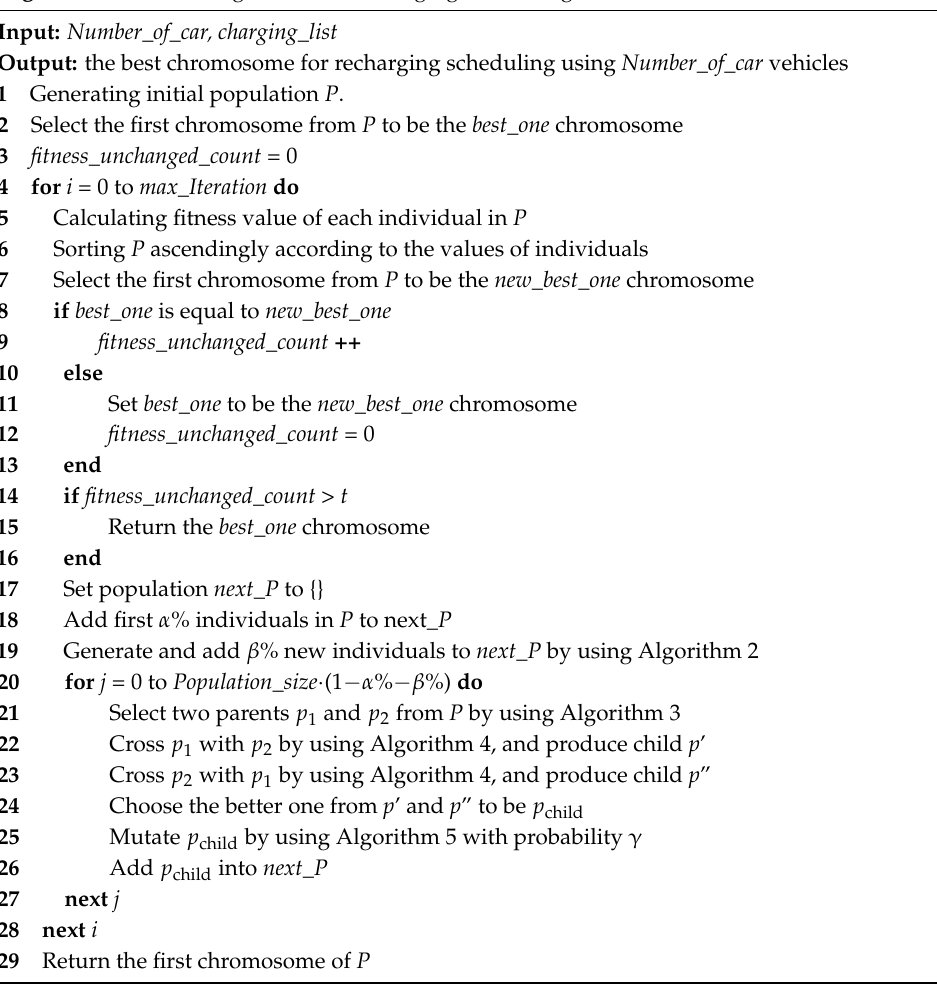
Algorithm 1. Genetic algorithm for recharging